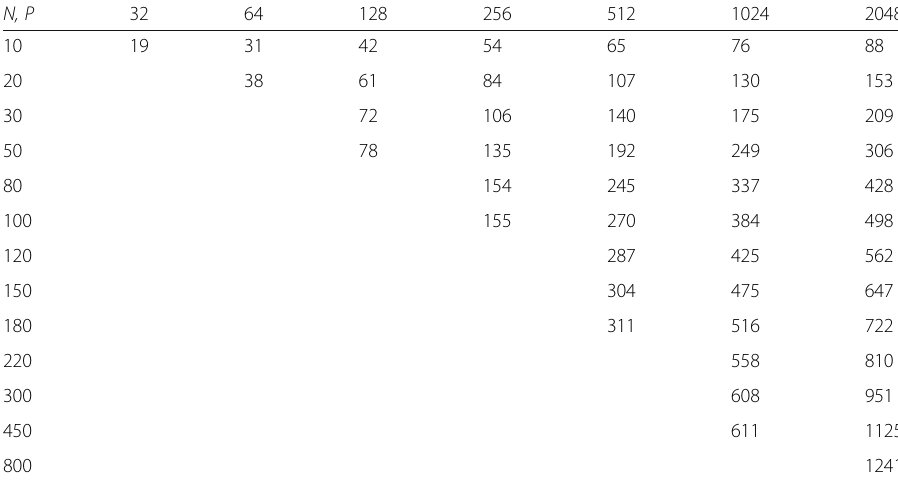
Table 6 The influence of sparsity and signal length on sampling length N,